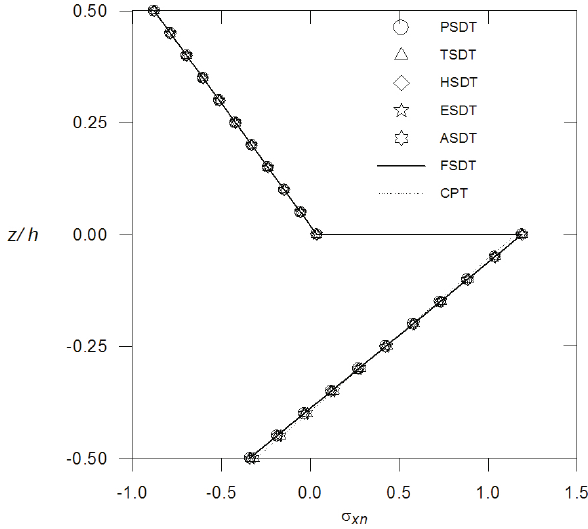
Figure 2: Variation of normalized in-plane normal stress σ x across the thickness for two layered (0 ∘ /90 ∘ ) anti-symmetric laminated composite square plate for aspect ratio ( b / h ) 10.